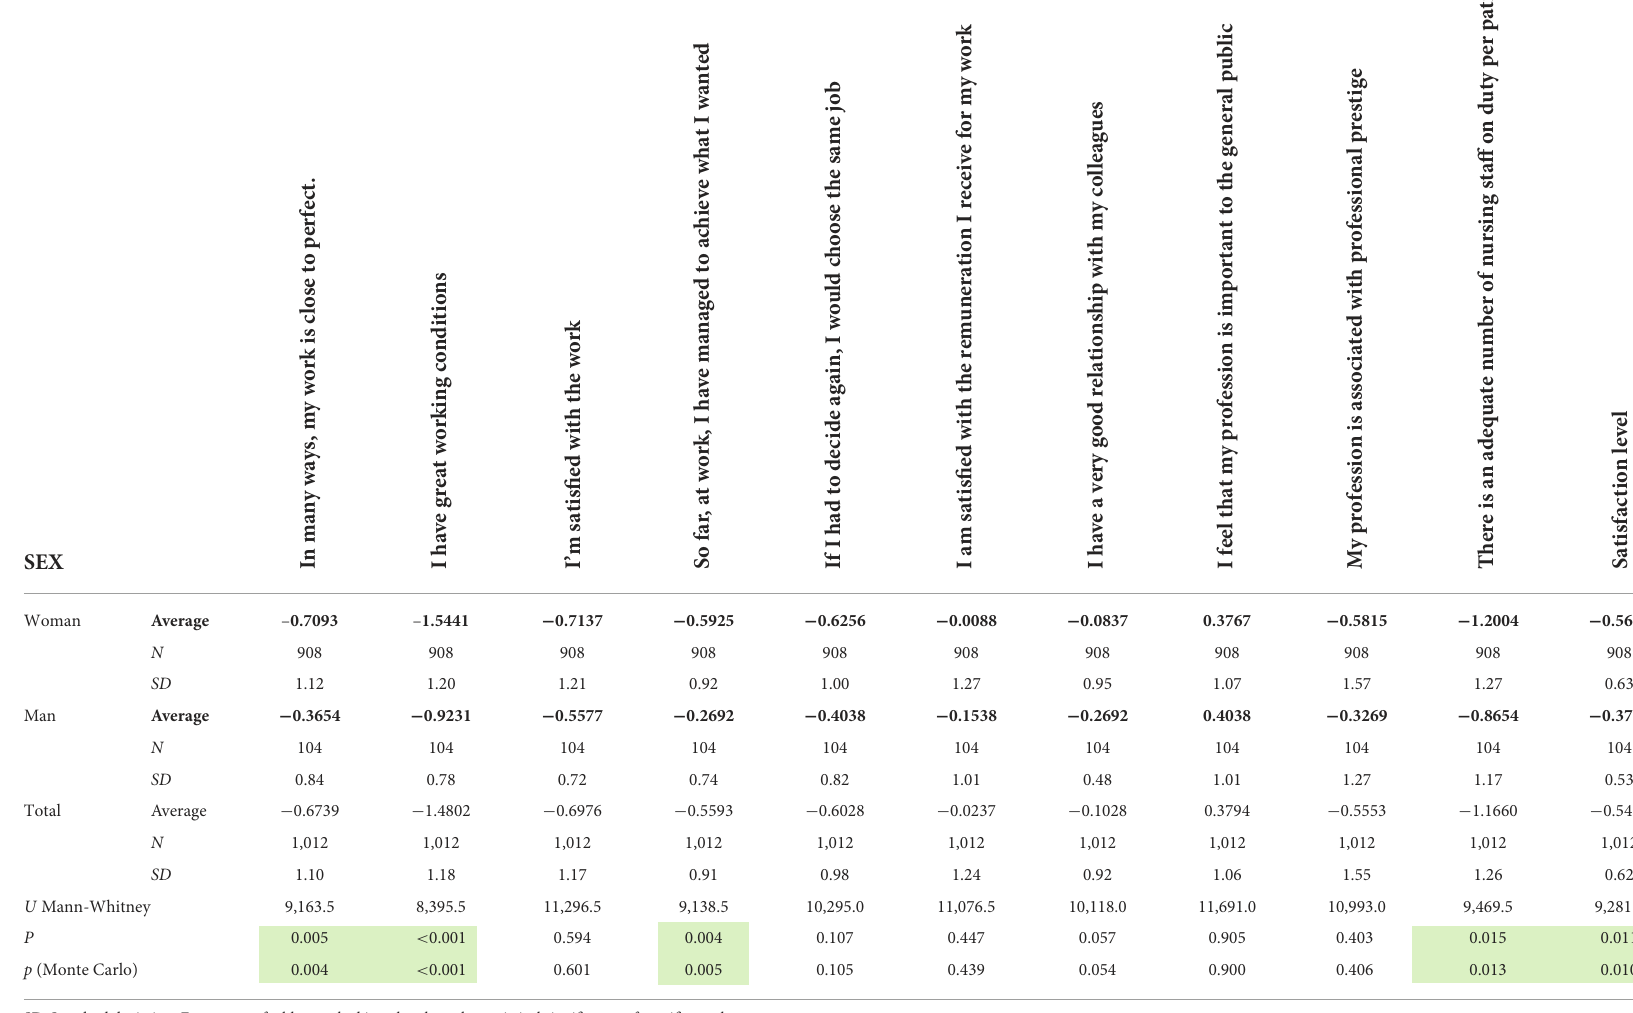
TABLE 5 Change in satisfaction with professional work during the COVID-19 pandemic and the gender of the surveyed